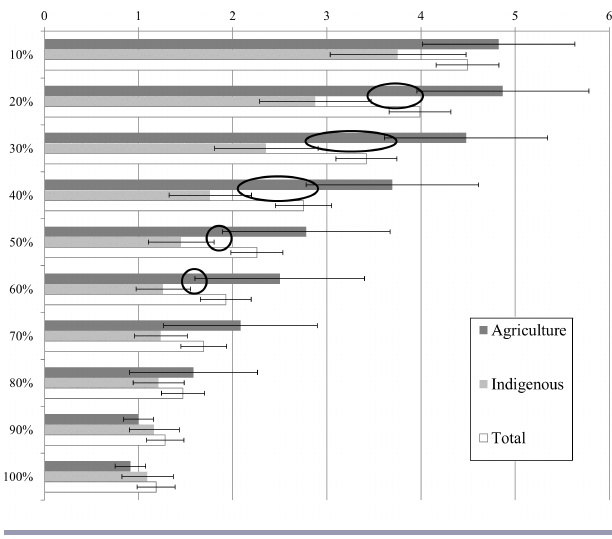
Fig. 6 . Mean satisfaction (0 being much more dissatisfied and 9 being much more satisfied) and confidence intervals for percentages of clearing in the catchment for three groups of respondents: those who earn an income from agriculture, indigenous respondents, and total respondents. Significant differences between agricultural and indigenous respondents are